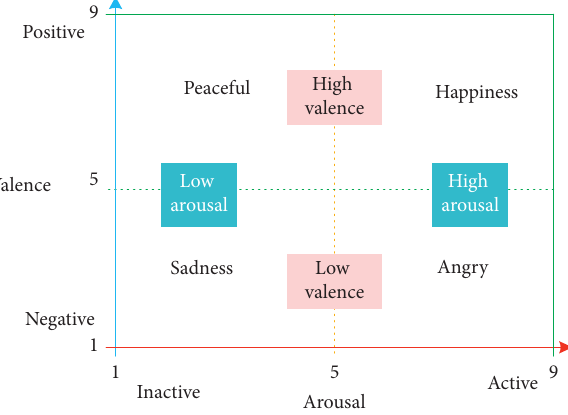
Figure 2: Two-dimensional space of the emotion